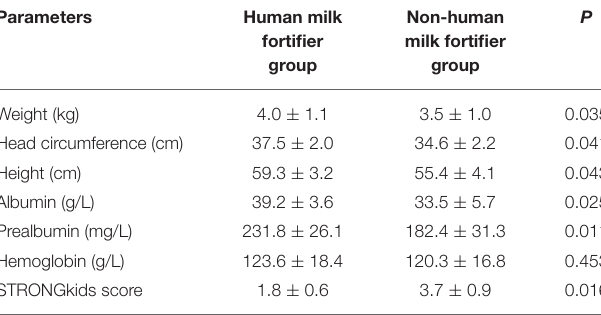
TABLE 3 | Comparison of nutritional status between the two groups after the intervention.